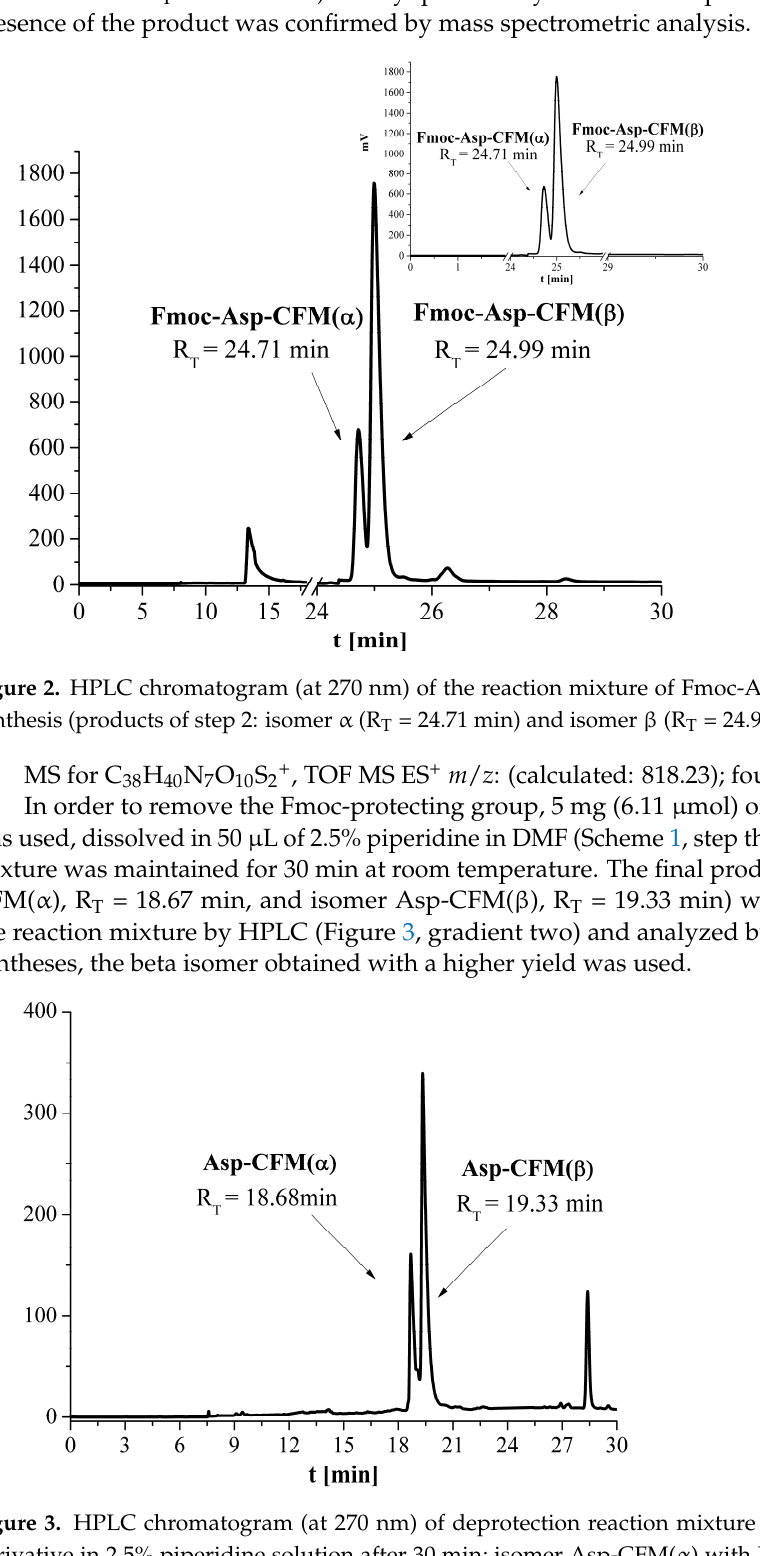
7 of 16 Figure 1. HPLC chromatogram (at 280 nm) of the reaction mixture of Fmoc-Asp-anh synthesis (R T = 17.11 min, gradient 1).